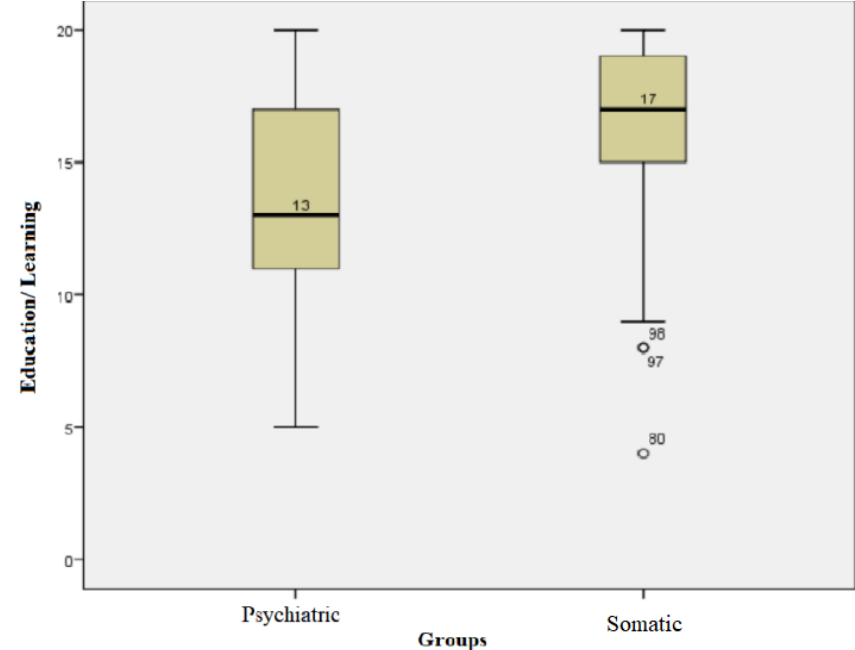
Figure 4. Education/learning field for both groups. For the conflict/aggression, avoidance, and rivalry domains, the t-test for independ- ent samples showed that there were no statistically significant differences between the median values between the two groups. In the somatic group, 66% of the patients had at least one sibling with an age greater than or equal to 11 years and 52% had siblings with younger than or equal to 10 years old. In the psychiatric group, 78% of the patients had at least one sibling of more than or equal to 11 years of age and 42% had siblings less than or equal to 10 years of age. There were no significant differences between the groups ( p = 0.405, df = 2, Chi-square = 1810). The subjects in the psychiatric group, whose siblings were at least 11 years old, had rivalry score values ranging from a minimum of 7 to a maximum of 35, with an average+/- SD of 15.28+/−5.612 and a median of 14. For those with siblings under or equal to 10 years of age, values ranging from a minimum of 13 to a maximum of 25 were obtained, with an average+/- SD of 18.73+/−39 52 and a median of 18. The distributions of values for both groups were non- parametric. The Mann−Whitney test showed that there was a statisti- cally significant difference between the medians of the values in the two groups, so where there were siblings under the age of 10, rivalry scores tended to be higher (U = 83.50, p = 0.02) (Figure 5).